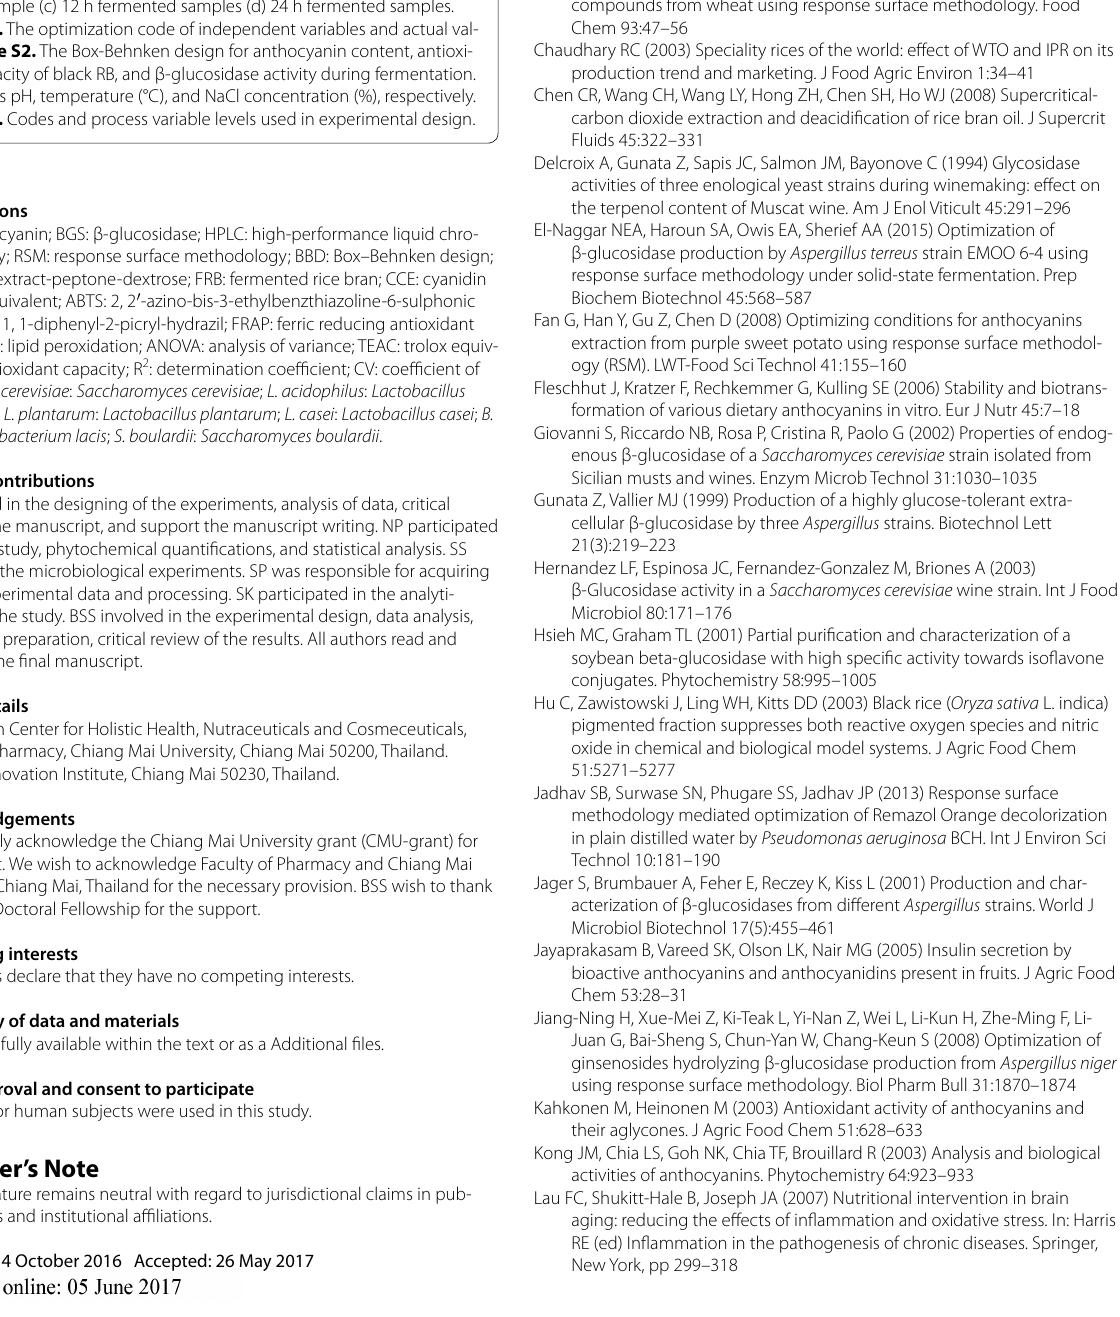
Figure S2. Representative Chromatograms showed the variation in phe- nolic acid content of RB during fermentation. (a) Phenolic acid standards (1. Protocatechuic acid, 2. Caffeic acid 3. Syringic acid, 4. p -coumaric acid), (b) 0 h sample (c) 12 h fermented samples (d) 24 h fermented samples. Table S1. The optimization code of independent variables and actual val- ues. Table S2. The Box-Behnken design for anthocyanin content, antioxi- dant capacity of black RB, and β-glucosidase activity during fermentation. X 1, X 2, X 3 is pH, temperature (°C), and NaCl concentration (%), respectively. Table S3. Codes and process variable levels used in experimental